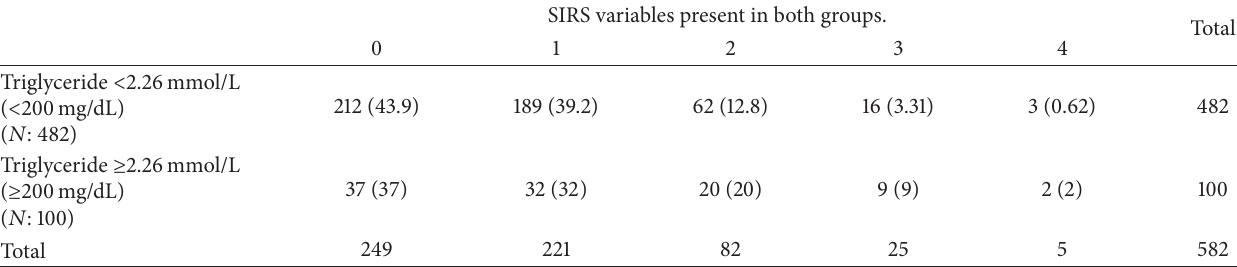
Table 6: Incidence of systemic inflammatory response syndrome (SIRS) in the two groups. SIRS variables present in both